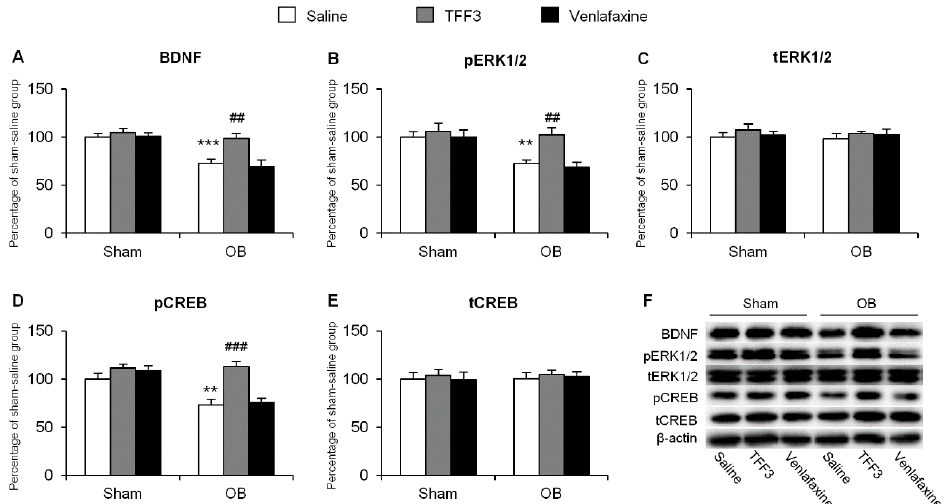
Figure 3. Effects of 7-day TFF3 treatment on BDNF expression and ERK1/2 and CREB phosphorylation in hippocampal CA3. The levels of BDNF ( A ); pERK1/2 ( B ); tERK1/2 ( C ); pCREB ( D ) and tCREB ( E ) in CA3 were detected using Western blot; ( F ) Representative band intensities of the Western blot. The data are expressed as mean ± SEM ( n = 6 per group). ** p < 0.01, *** p < 0.001, compared with sham-saline group; ## p < 0.01, ### p < 0.001, compared with OB-saline group. In dentate gyrus (DG), the two-way ANOVA of pERK1/2 data revealed the significant effects of surgery ( F (1,30) = 79.03, p < 0.001) but no significant effects of treatment ( F (2,30) = 0.06, p > 0.05) or surgery × treatment interaction ( F (2,30) = 0.37, p > 0.05, Figure 4B). The level of pERK1/2 was decreased by OB operation ( p < 0.001, Figure 4B) but 7-day TFF3 treatment had no significant effect. Besides, there was no significant change in the levels of BDNF, total ERK1/2, pCREB and total CREB (Figure 4A,C–E).